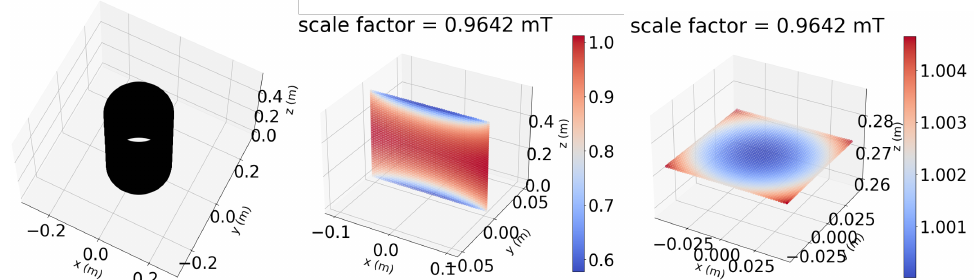
Figure 5. Geometry of the solenoid ( left ), magnetic field on the xz plane ( center ) and magnetic field on the xy plane ( right